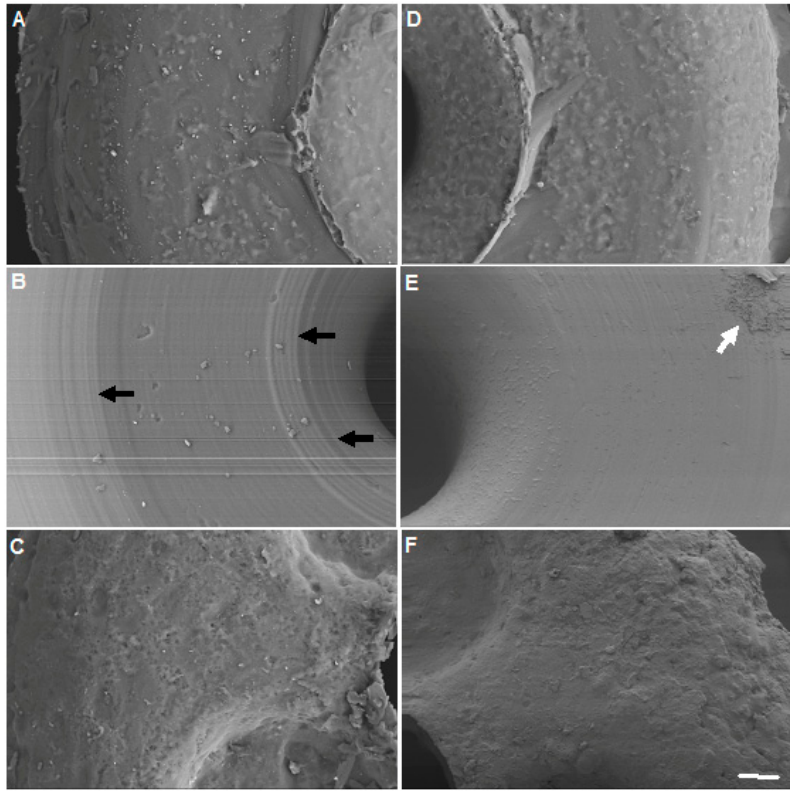
Figure 4. Surface and bacterial analyses of occluders. The top surface of the three types of unused (control) and with seven days in the presence of S. aureus (experimental) occluders were imaged using SEM. ( A ) Control Delta R ; ( B ) Control Odyssey R ; ( C ) Control Alphamed R ; ( D ) Experimental Delta R ; ( E ) Experimental Odyssey R and ( F ) Experimental Alphamed R . Black arrows indicate grooves on the unused Odyssey R occluder. White arrow indicates the presence of S. aureus biofilm on the Experimental Odyssey R occluder. Scale bar = 20 µ m.